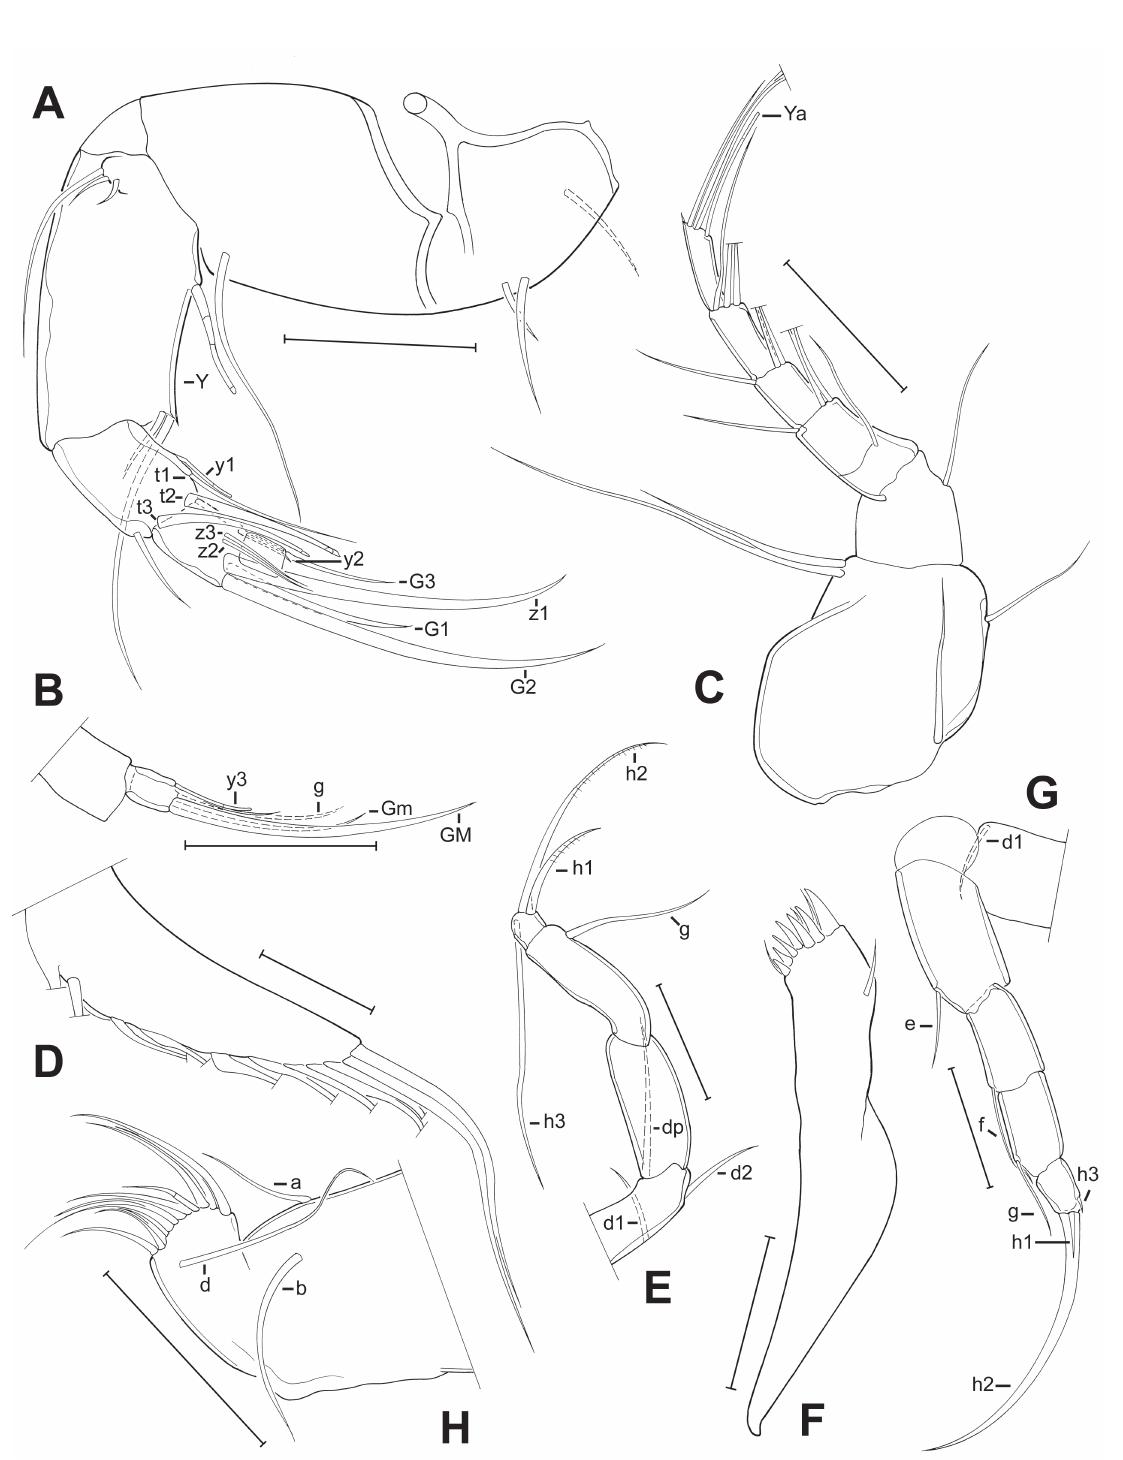
Fig. 3. Limbs of Pseudocandona agostinhoi sp. nov. (♂). A . A2 (MZUSP 32656). B . A2, detail of the last segment (MZUSP 32656). C . A1 (OC. 3302). D . Mx1, respiratory plate (OC. 3302). E . T3 (MZUSP 32655). F . Md, coxal plate (MZUSP 32653). G . T2 (MZUSP 32653). H . T1 (MZUSP 32653). Scale bars: A–H = 50 µ